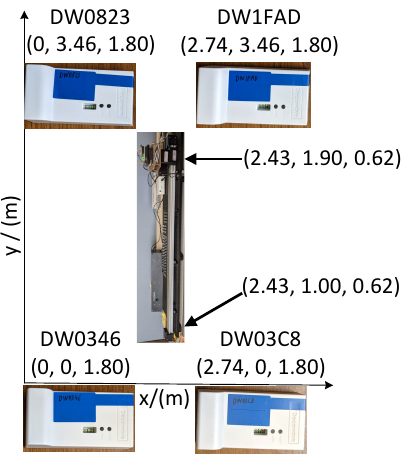
Figure 5. The arrangement of the four anchors and the test